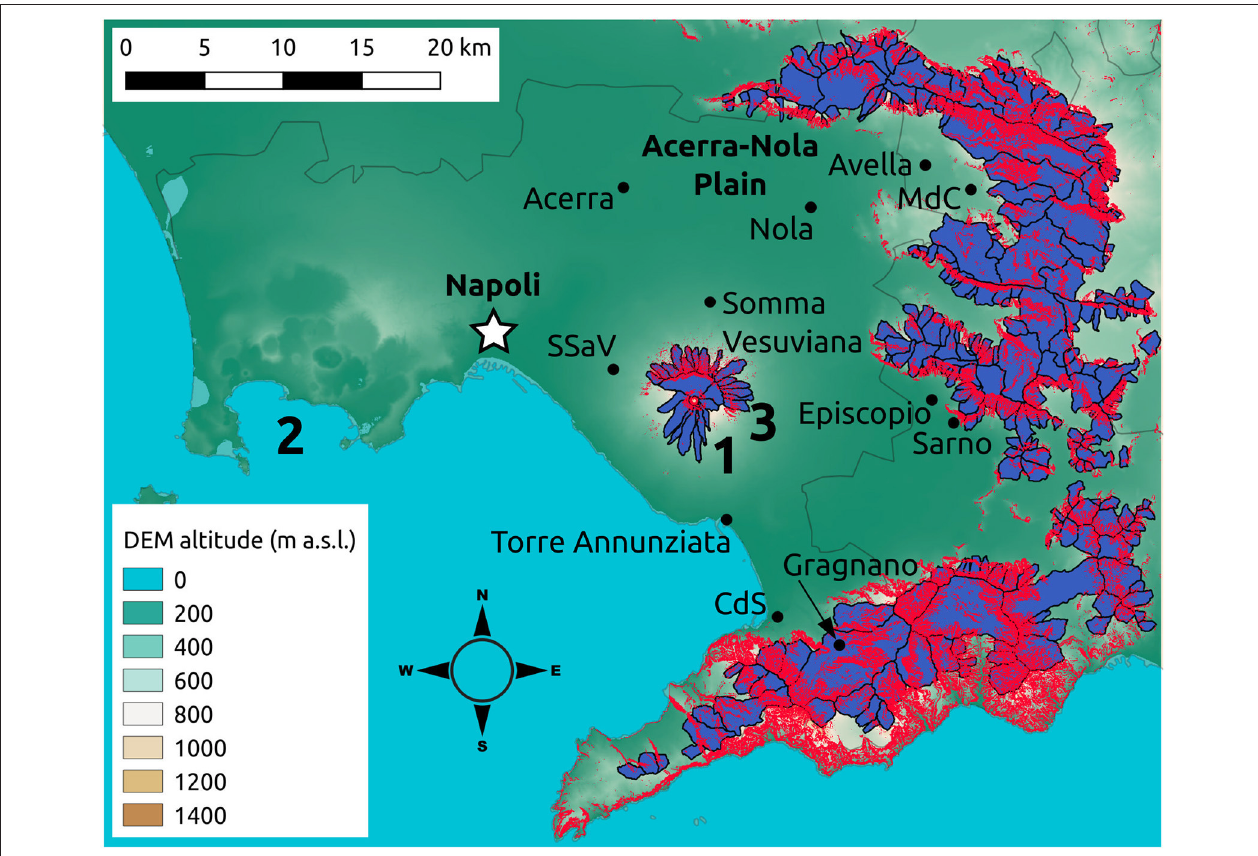
FIGURE 5 | Topographic map of Somma-Vesuvius (1) and surroundings which include the Campi Flegrei caldera (2), the city of Napoli (white star) and many other localities (some of them are reported in the map, see black dots. NB. CdS, Castellammare di Stabia; MdC, Mugnano di Cardinale; SSaV, San Sebastiano al Vesuvio). The catchments identified as having a potential to generate rain-triggered lahars after explosive eruptions at Somma-Vesuvius are shown in blue. Red areas indicate the grid points inside the 20 m-resolution DEM with slope > 30 ◦ . The horse-shoe shape of Mount Somma (3) is evidenced by grouping of steep-slope points slightly north of the current crater of Somma-Vesuvius. We also indicate the location of the Acerra-Nola Plain, about 15–20 km northwards from the current